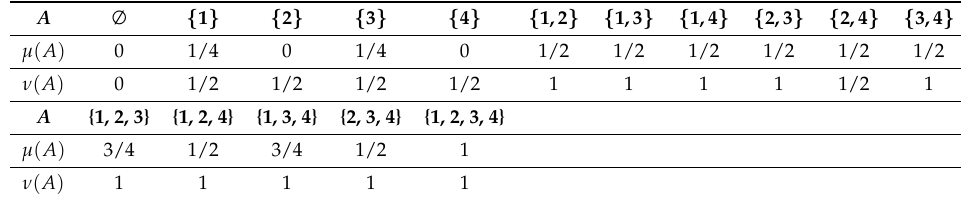
Table 1. Values of capacities µ and ν from Example